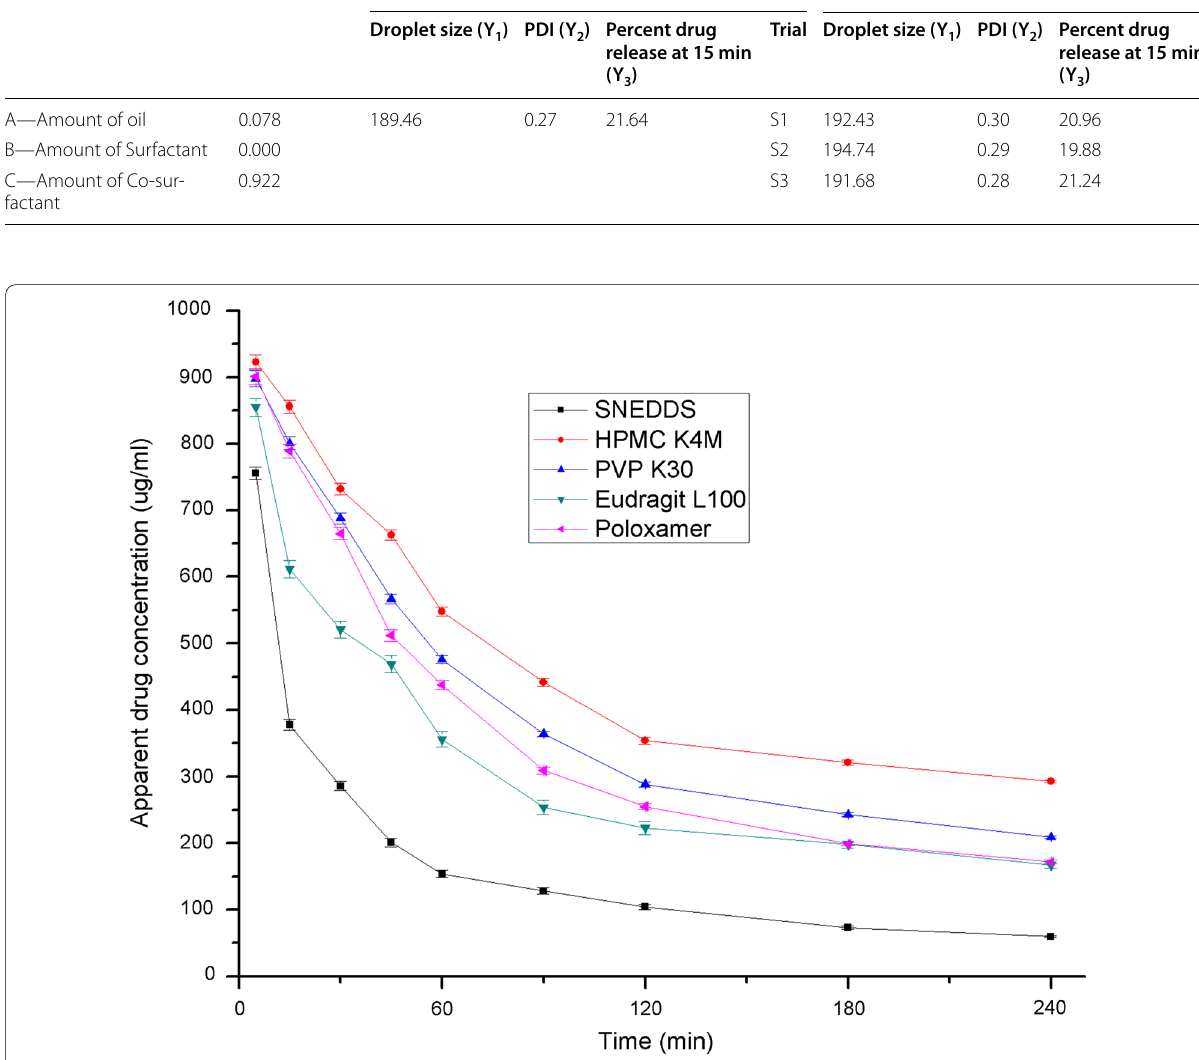
Fig. 8 The drug concentration–time profiles with various